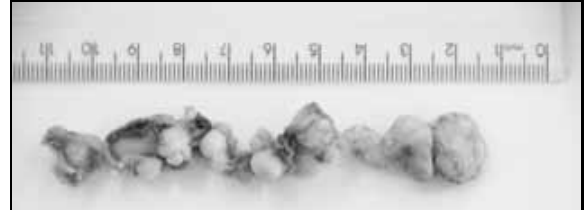
Figura 1 – Imagem ultrassonográfica